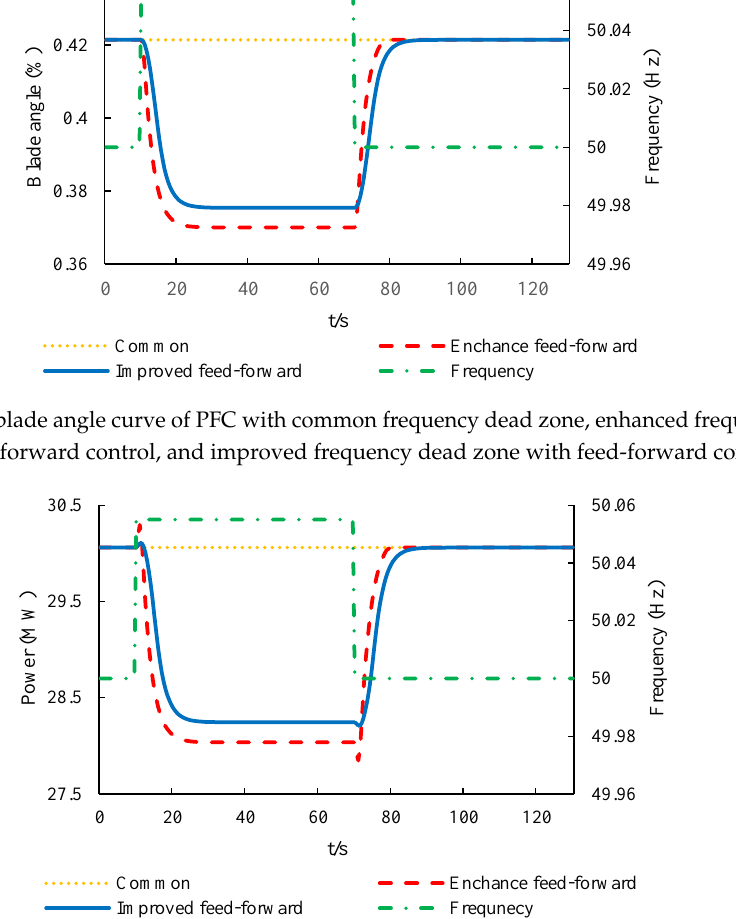
Figure 19. The active power curve of PFC with common frequency dead zone, enhanced frequency dead zone with feed-forward control, and improved frequency dead zone with feed-forward control.